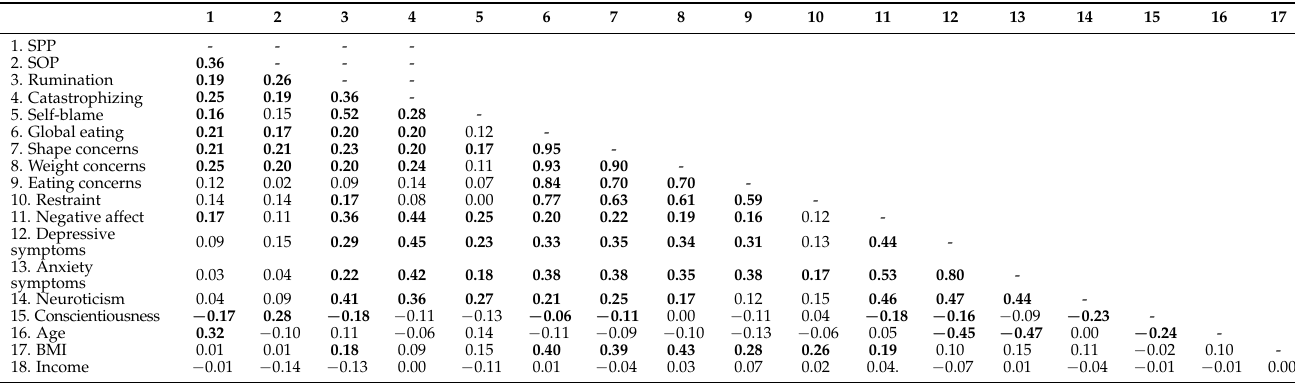
Table 2. Zero-order correlations between variables of